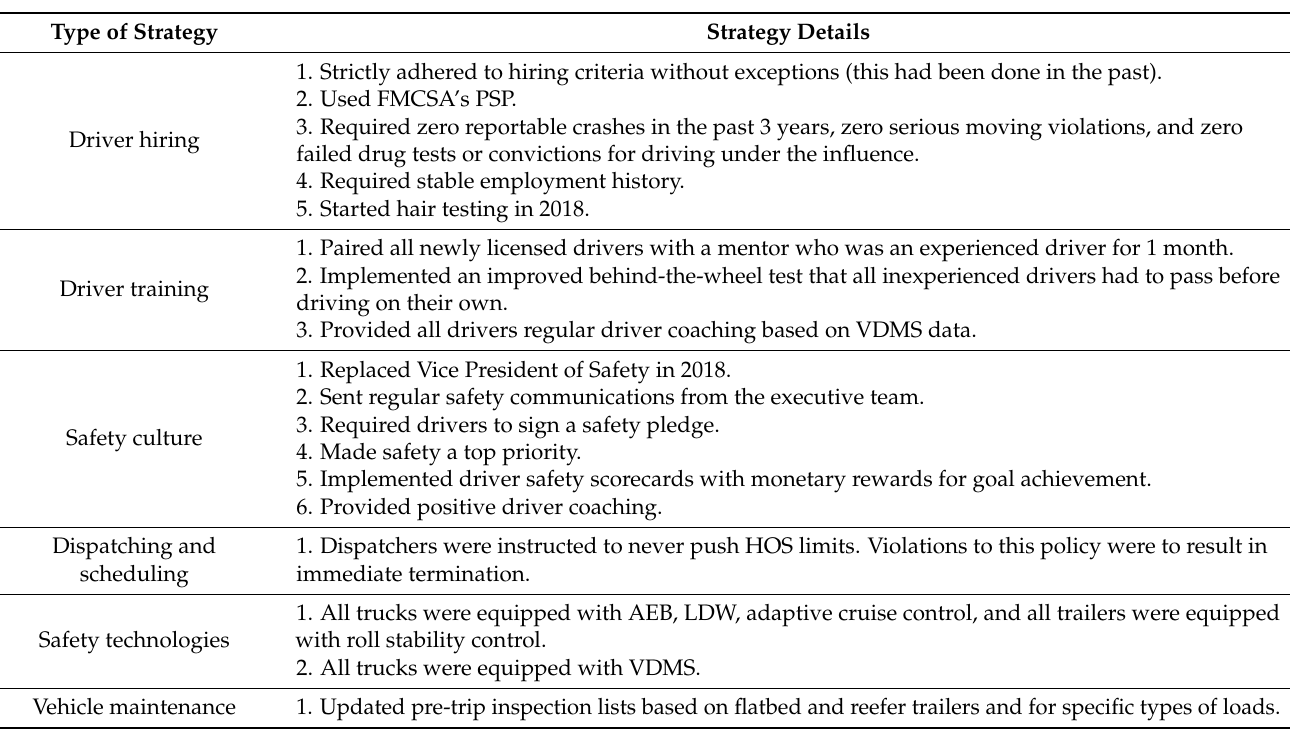
Table 4. Fleet B’s safety improvement strategies.